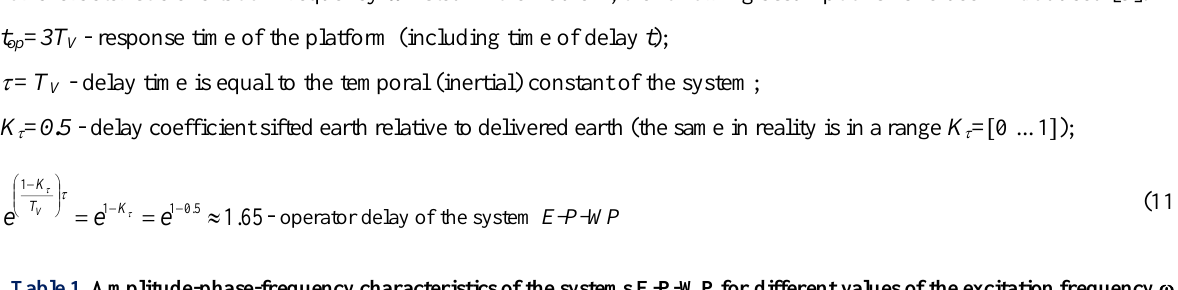
Table 1. Amplitude-phase-frequency characteristics of the systems E-P-WP for different values of the excitation frequency  . Characteristic point